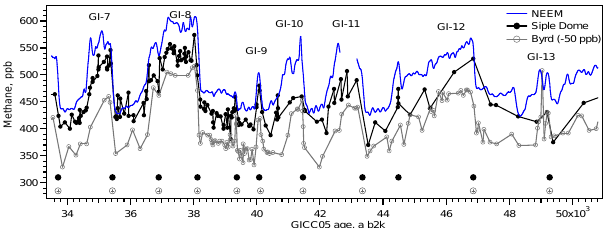
Figure A1. Construction of a gas age scale for the Byrd and Siple Dome ice cores, Antarctica. Blue line: NEEM methane data (Chap- pellaz et al., 2013) on the NEEM GICC05 gas age scale (Guillevic et al., 2013; Rasmussen et al., 2013). Black line and dots: Siple Dome CH 4 data (Brook et al., 2005; Ahn et al., 2012) after syn- chronisation. Grey line and open circle: Byrd CH 4 data (Ahn et al., 2012) minus a 50ppb offset for better clearness, after synchroni- sation. At the bottom of the figure are indicated the position of the match points listed in Table A1: black circles for NEEM-Siple Dome match points and open grey circles for